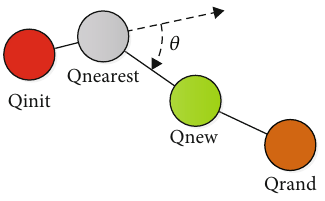
Figure 4: Extended diagram of the F-RRT ∗